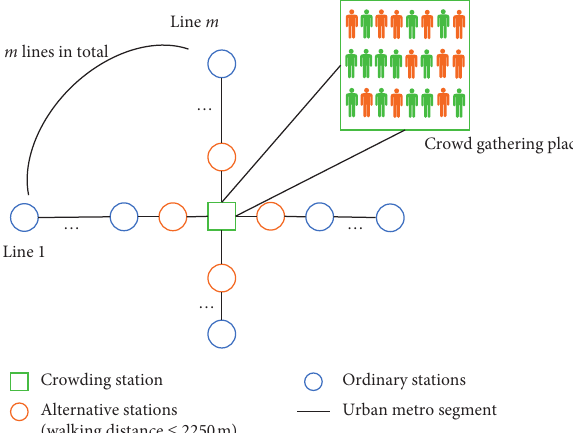
Figure 1: Illustration of urban metro lines and urban metro stations. The green square represents the crowding station, and the black lines represent the urban metro segments. The orange circles and the blue circles represent the alternative stations and the ordinary stations, respectively. The passengers colored in orange represent the passengers who walk to the crowd gathering place, whereas the passengers colored in green represent the passengers who take urban metro to the crowd gathering place.